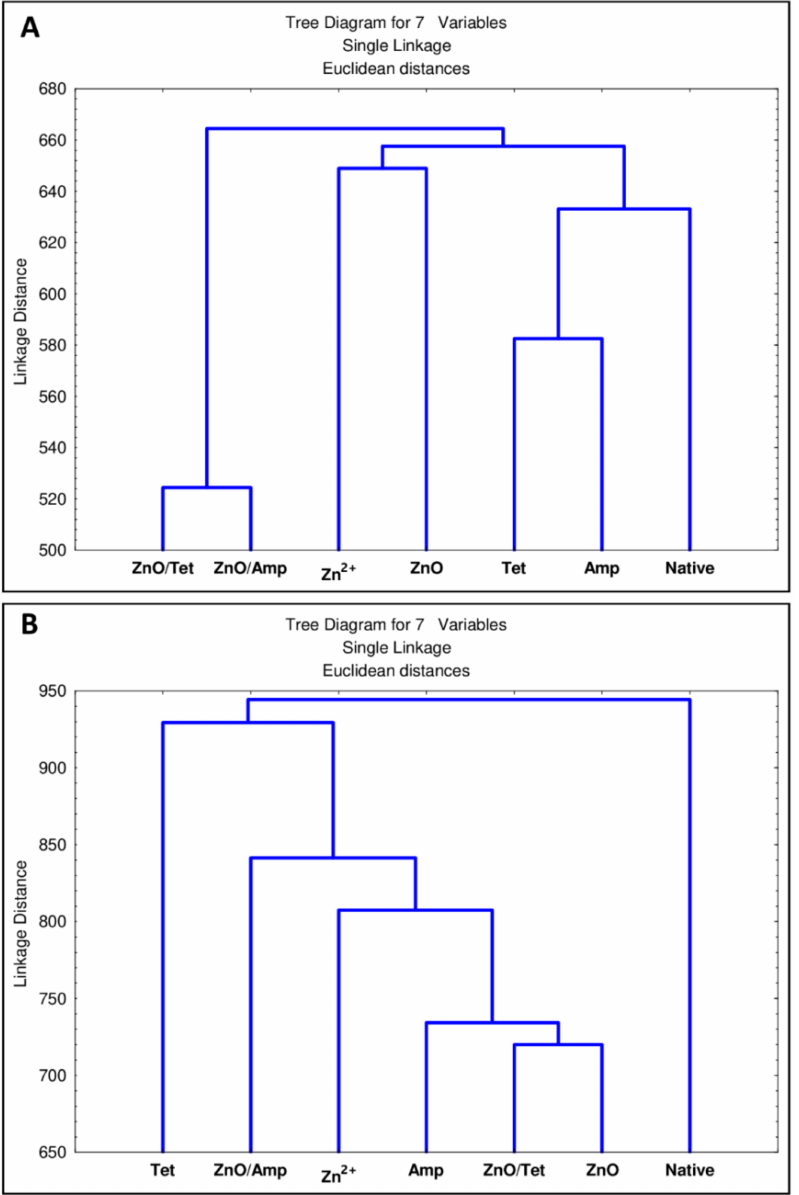
Figure 12. The statistical significance of differences in the protein ( A ) and lipid ( B ) profiles of E. coli , S. epidermidis and K. pneumoniae after their incubation with zinc ions, ampicillin, tetracycline and zinc oxide nanoparticles, before and after immobilization with